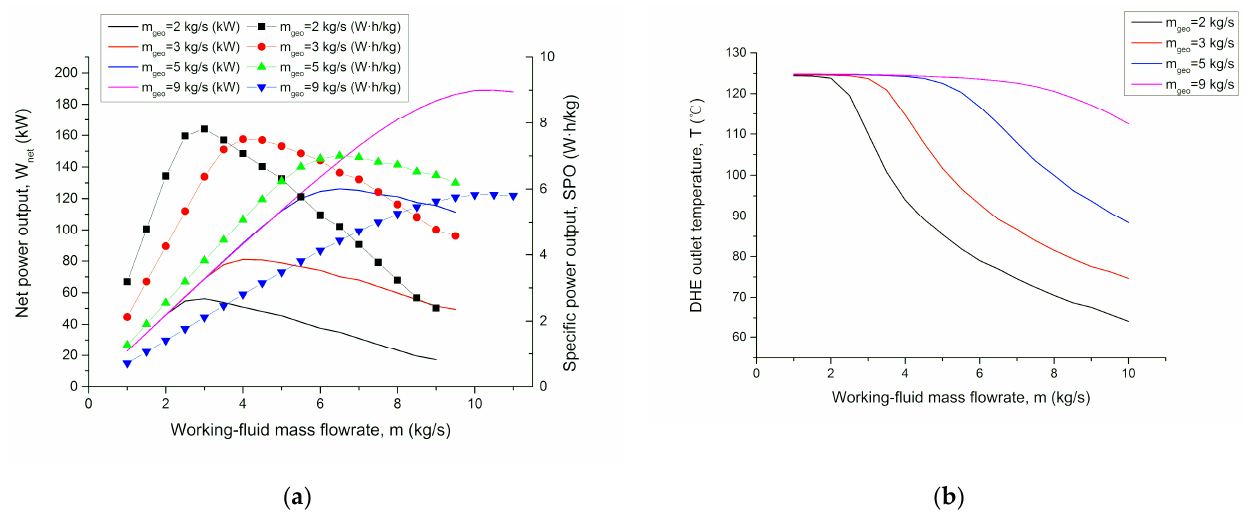
Figure 4. Effect of geofluid flowrate on the net power output and corresponding specific power output ( a ), and working-fluid’s DHE outlet temperature ( b ) (working-fluid’s DHE inlet pressure = 11 MPa, mass fraction of R32/CO 2 = 0.5/0.5, geofluid temperature = 130 °C, DHE length = 300 m).